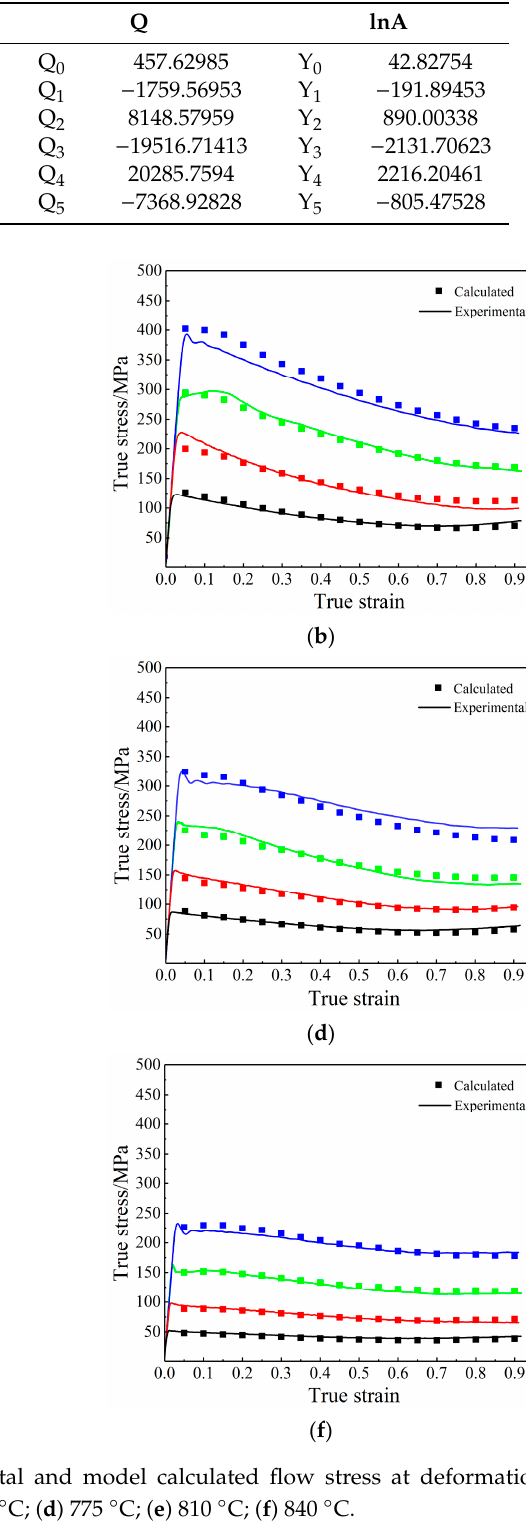
Figure 7. Correlations between experimental and model calculated flow stress.